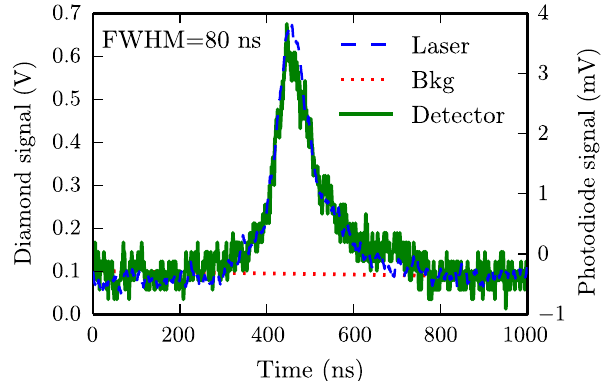
FIG. 10. Zoom on one of the diamond signals of Fig. 9 (solid — inverted), compared to the corresponding laser pulse (dashed). Dotted trace — linear fit of the